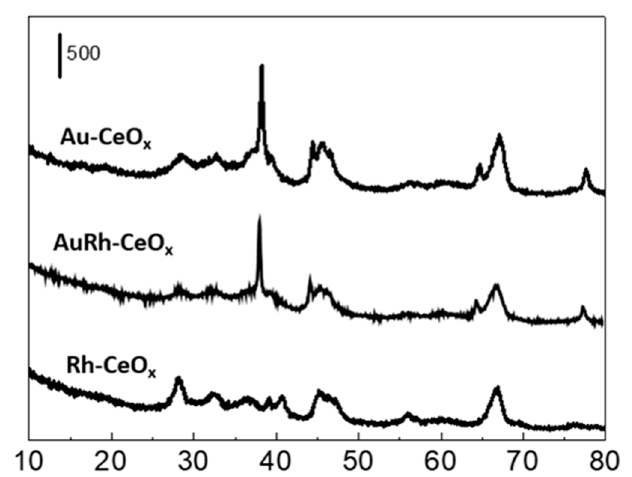
Catalysts 2019 , 9 , 937 Figure 8. XRD patterns of Rh–CeO x /Al 2 O 3 , AuRh–CeO x /Al 2 O 3 , and CeO x /Al 2 O 3 catalysts. Figure 8. XRD patterns of Rh–CeO x / Al 2 O 3 , AuRh–CeO x / Al 2 O 3 , and CeO x / Al 2 O 3 catalysts.